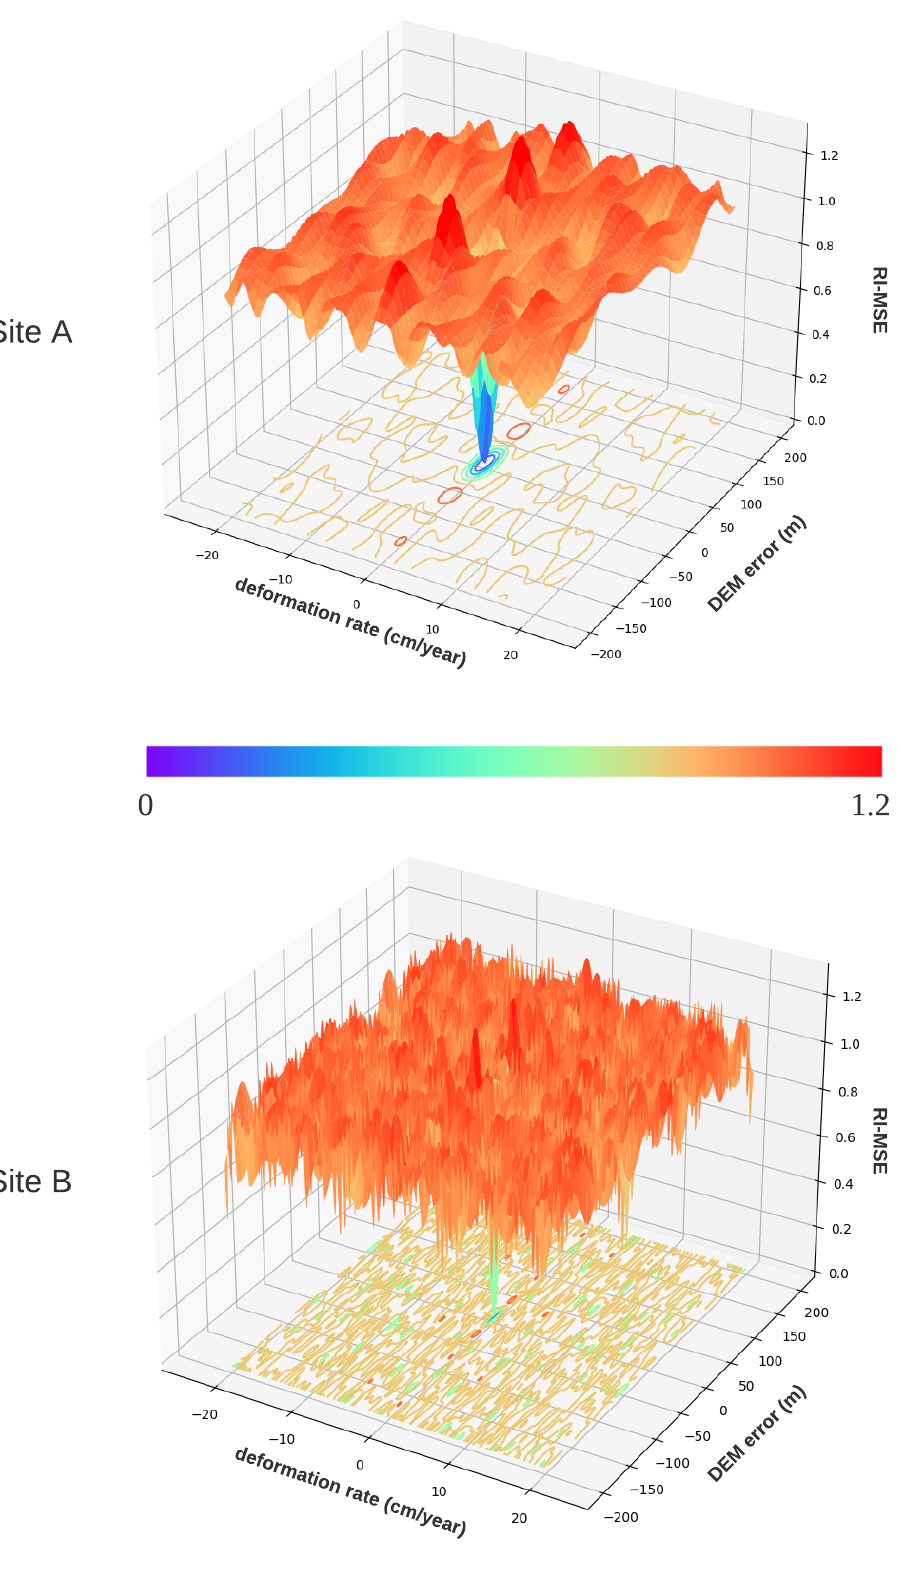
Figure 3. Loss landscape of objective function RI-MSE (Equation (7)) with two different real-world spatial and temporal baselines. Site ( A ) and Site ( B ) are two different real-world